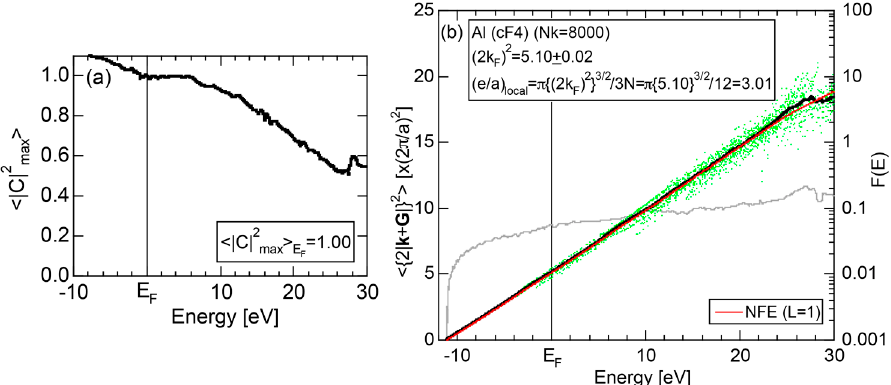
(cid:68) (cid:69) | C | 2 and ( b ) Hume-Rothery plot for Al (cF4) [11]. See captions of Figure 19b for max E